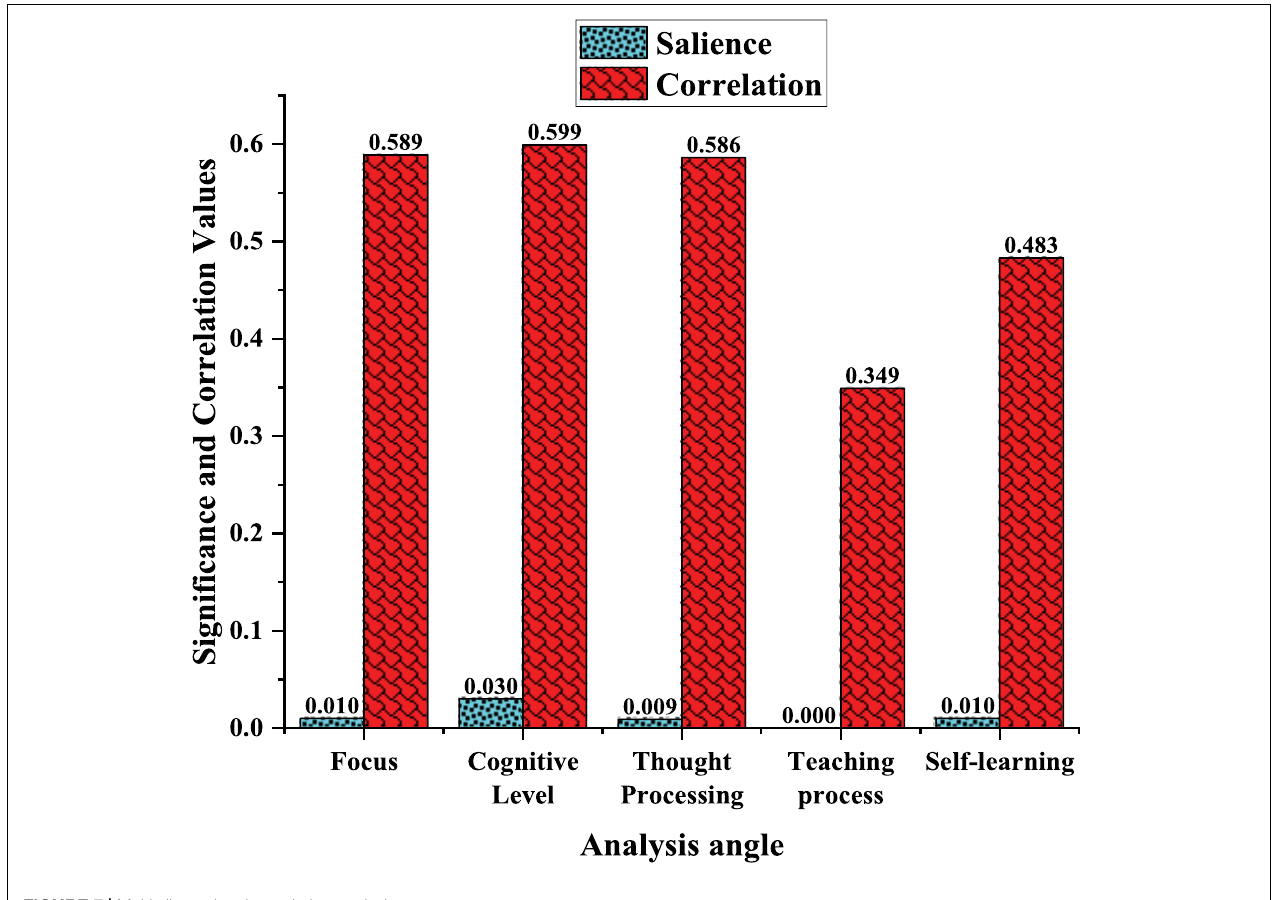
FIGURE 7 | Multi-dimensional correlation